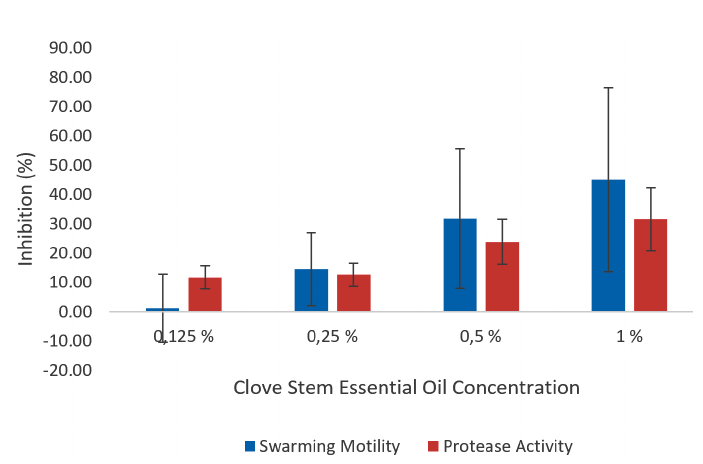
Fig. 8. P. aeruginosa quorum sensing inhibition by clove stem essential oil